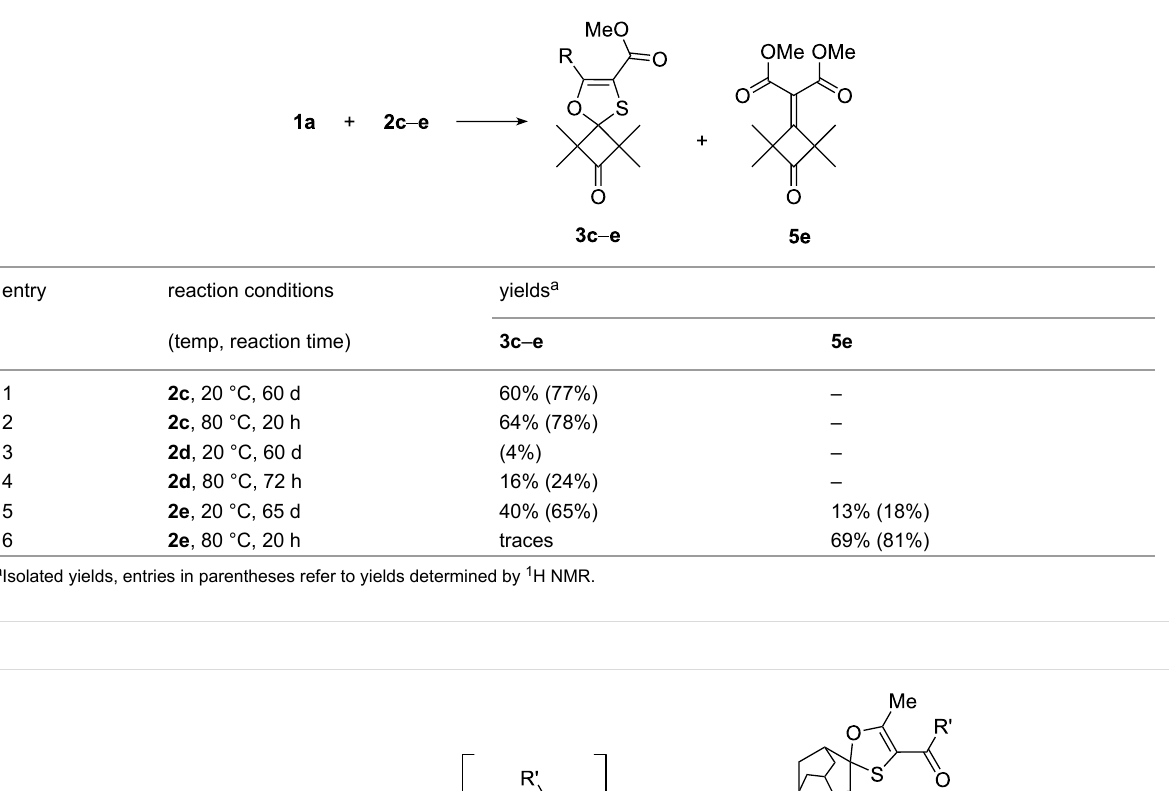
Table 2: Reactions of diazoketoesters 2c – e with thioketone 1a